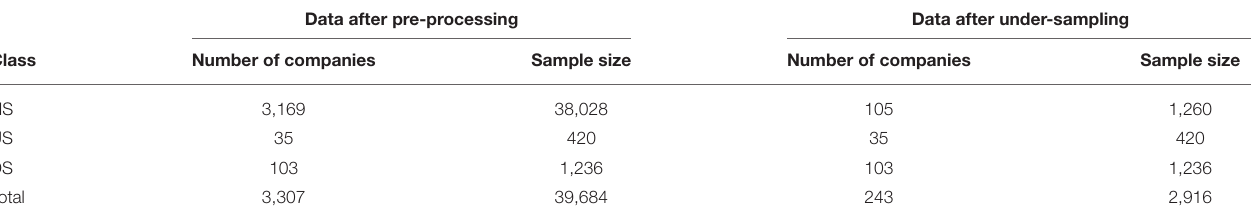
TABLE 3 | Sample size before and after under-sampling.